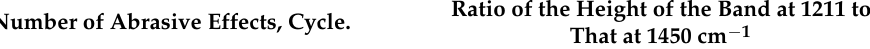
Ratio of the Height of the Band at 1211 to That at 1450 cm − 1